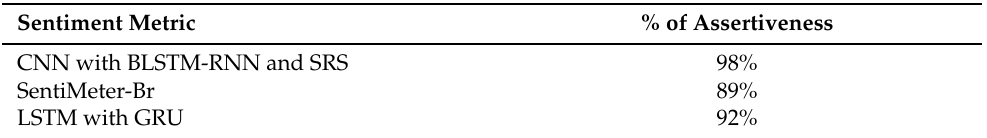
Table 5. Results of comparison of the CNN with BLSTM-RNN and SRS with other metrics in relation to the subjective tests in